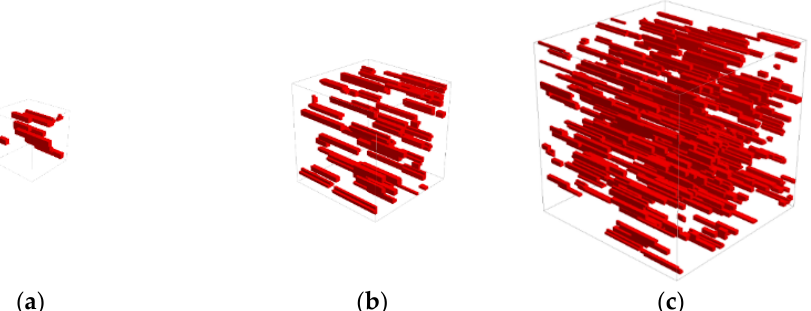
Figure 3. RVE models according to CNT length: ( a ) C l / R L = 0.17, ( b ) C l / R L = 0.67, and ( c ) C l / R L = 0.1.